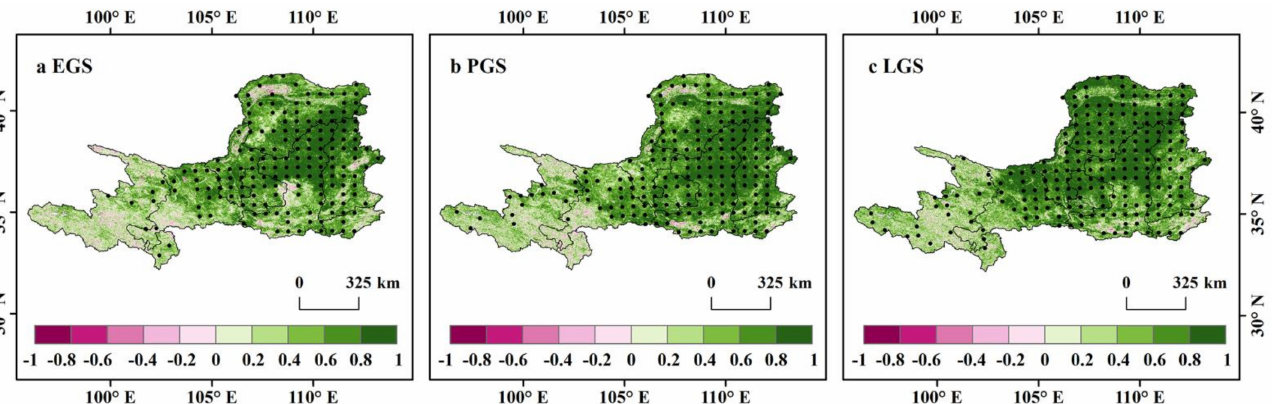
Figure 3. Partial correlation coefficients between 20-year seasonal NDVI time series and concurrent climate factors (temperature, TEM, precipitation, PRE, and sunshine duration, SSD), and climate factors (TEM ps , PRE ps , and SSD ps ) and NDVI (NDVI ps ) of the preceding season. The color block size represents the element value size. Squares with black outlines show statistically significant correlations at the 95% confidence level.